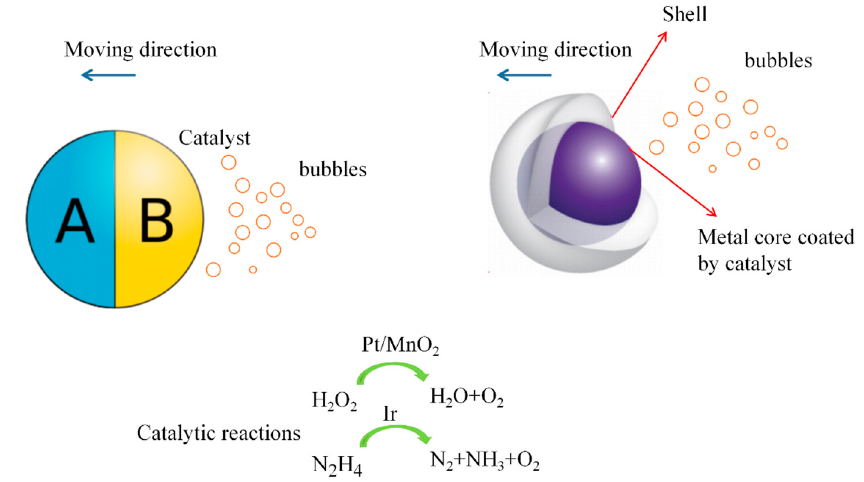
Figure 1. A Janus micromotor is designed by half-coating catalyst onto one side or coating catalyst onto the metal core of a nanoshell motor. Catalytic reactions produce gas to bring the motor forward. Small oxygen bubbles are formed, and they continue to grow under the supply of dissolved oxygen molecules. The detachment of bubbles acts as a net momentum on the motor, and induces a propulsion force and an initial velocity towards the opposite side.